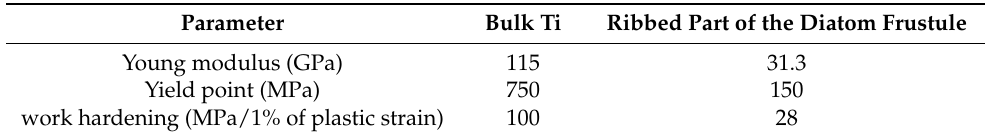
Table 1. Values of the characteristic mechanical properties for bulk Ti and equivalent parameters for the ribbed part of the diatom frustule. Parameter Bulk Ti Ribbed Part of the Diatom Frustule Young modulus (GPa) 115 31.3 Yield point (MPa) 750 150 work hardening (MPa/1% of plastic strain) 100